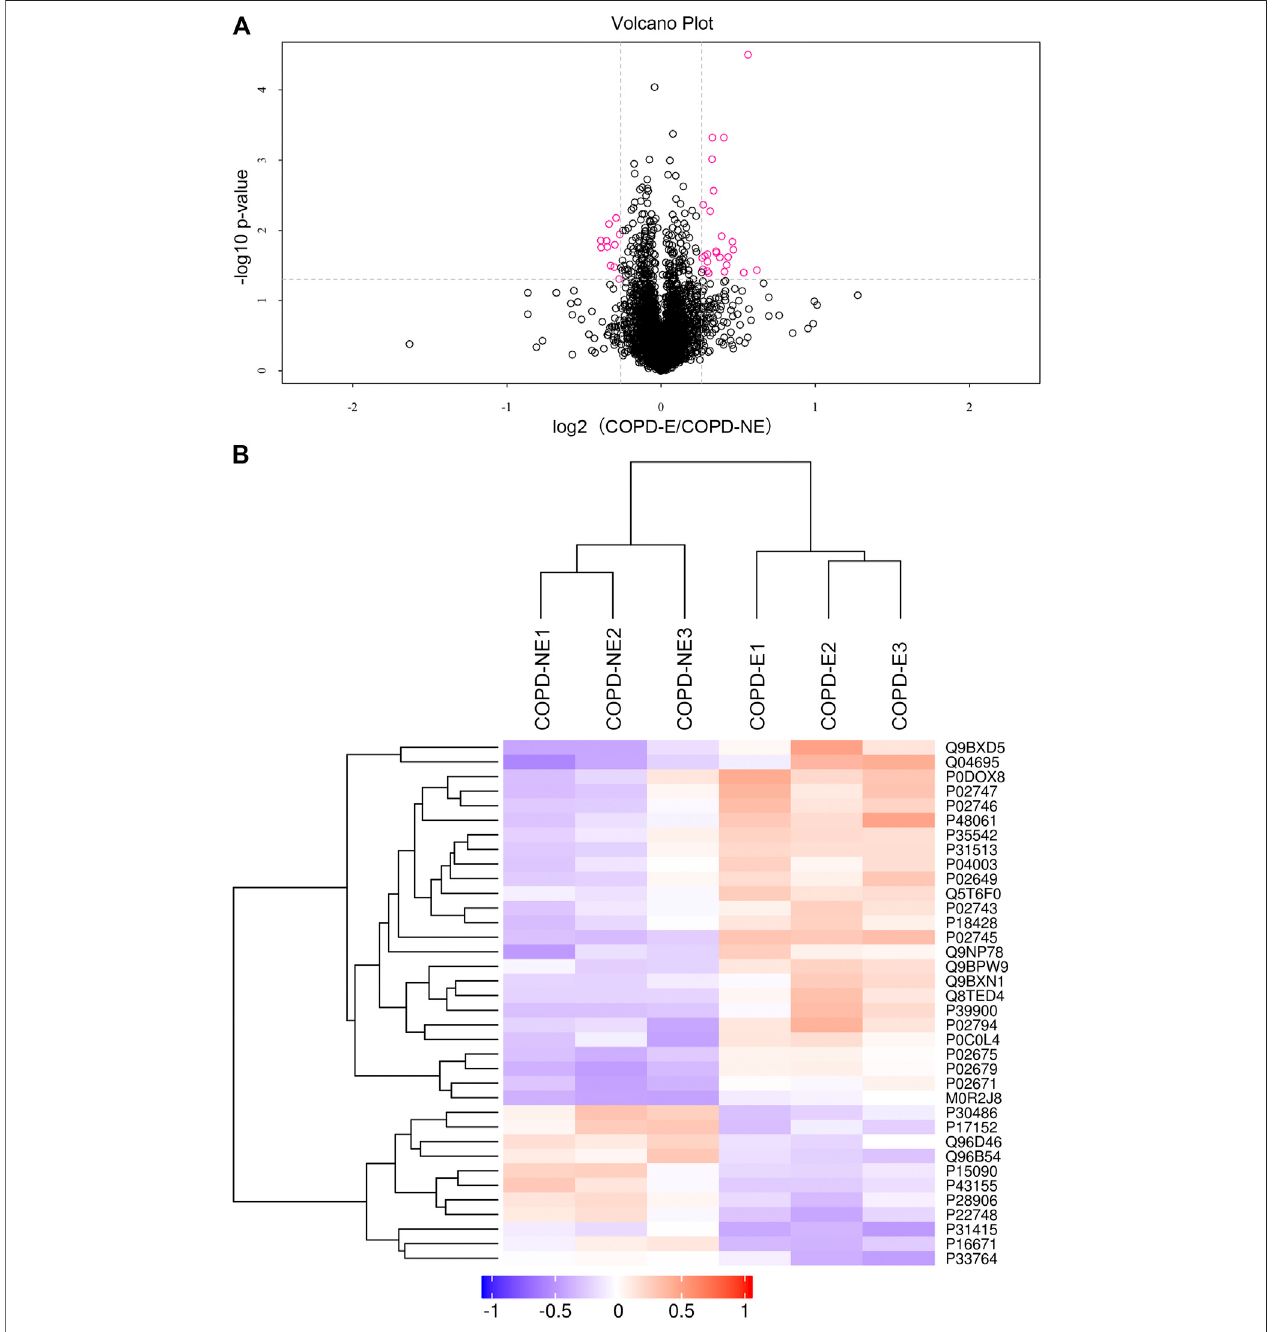
FIGURE 2 | Quanti fi cation and hierarchical clustering of differential abundant proteins (DAPs) in COPD emphysmetous phenotype. (A) Volcano plot of DAPs. (B) Hierarchical clustering heat map of DAPs.